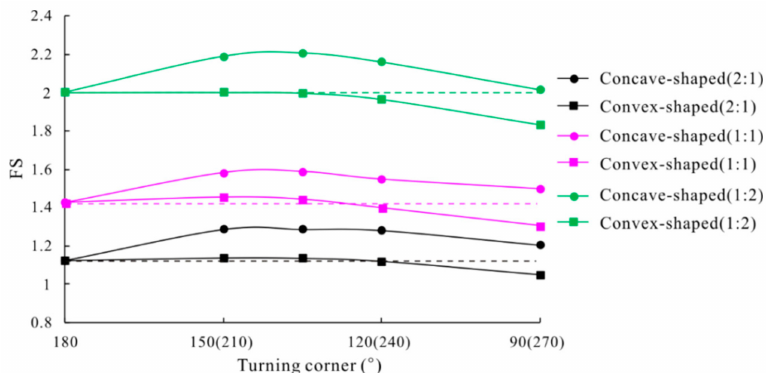
Figure 6. Variation of safety factor with turning the corner under the initial